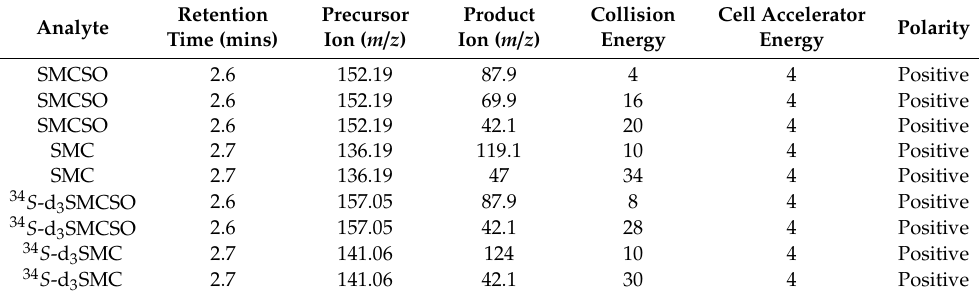
Table 1. Liquid chromatography-mass spectrometry (LC-MS) / MS parameters of S -methyl- l -cysteine sulfoxide